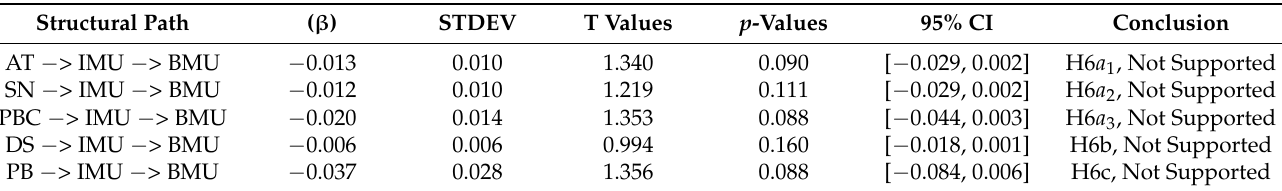
Table 7. Significant testing results of the total